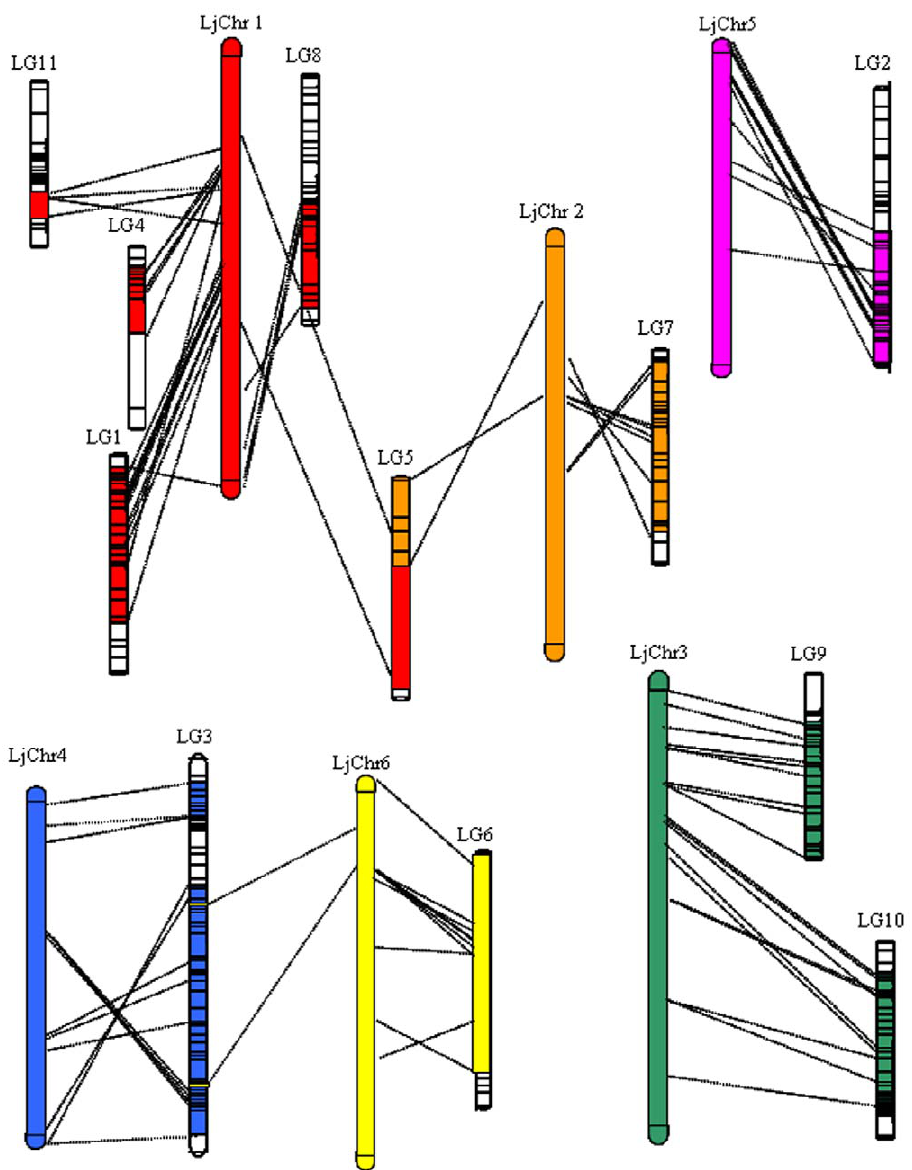
Figure 3. A synteny map between asparagus bean and Lotusjaponica . Chromosomes of L. japonica are marked with LjChr,while asparagus bean linkage groups are marked with LG.